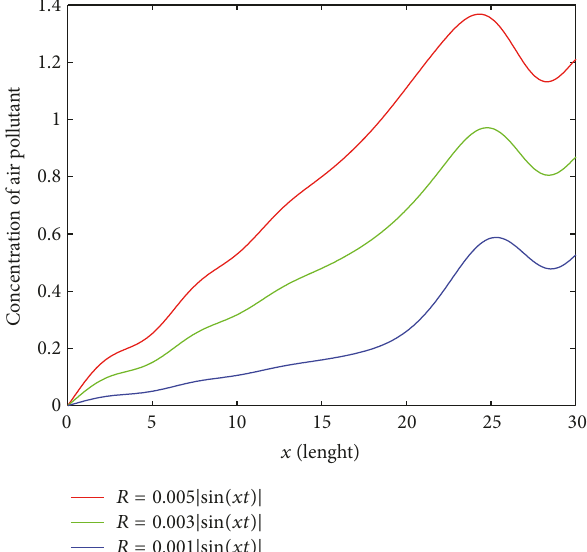
Figure 22: Compare the concentration of air pollutant at 𝑥 = 60 m , 𝑦 = 14 m , 𝑧 = 4 m of sources in different time.